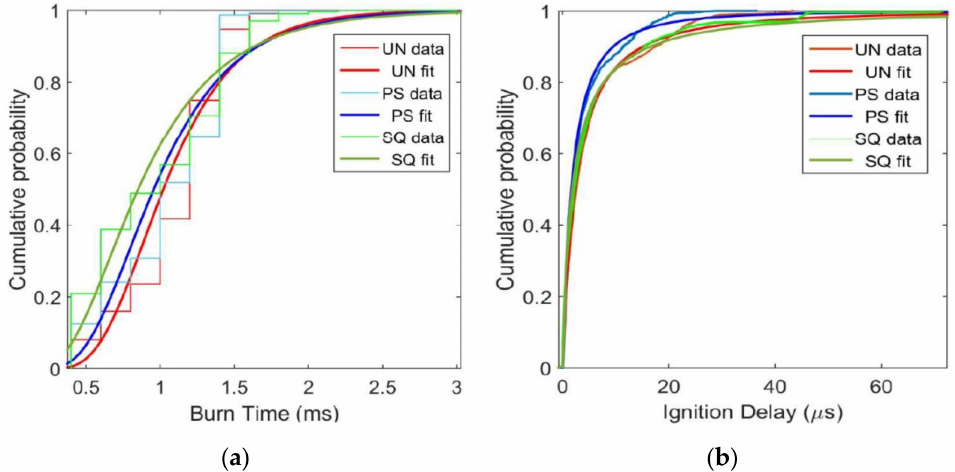
Figure 2. Cumulative probability of: ( a ) burn time and ( b ) ignition delay for untreated Al powder (UN Al), pre-stressed Al powder (PS Al) and super-quenched Al powder (SQ